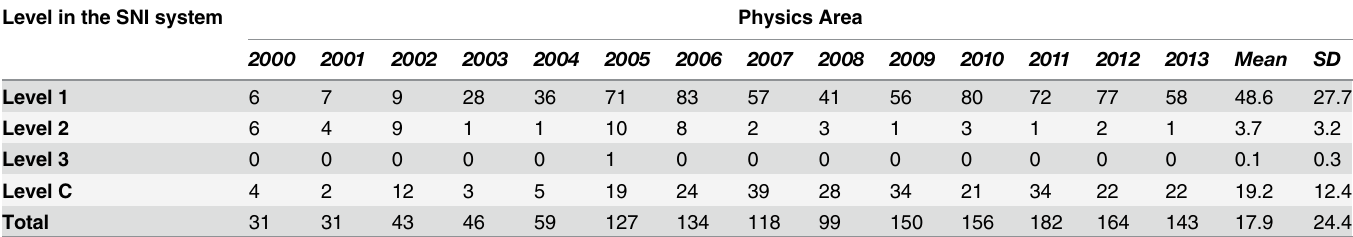
Table 8. Distribution of the average of papers produced by year by the Mexican Diaspora vs. level in the SNI of the physics area. Level in the SNI system